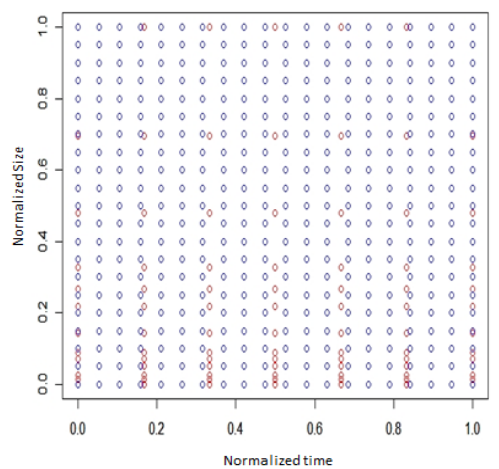
Figure 10. Spatial positioning of the experimental data (red) and meta-model data (blue).